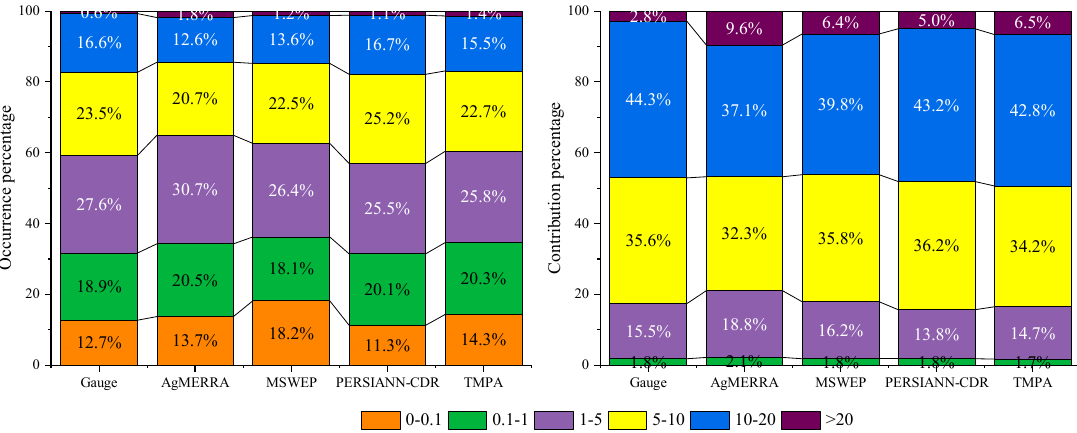
Figure 3. The intensity distribution of daily precipitation in different ranges (0~0.1, 0.1~1, 1~5, 5~10, 10~20, and >20 mm/day), and their relative contribution to the total precipitation amounts during the period 1998 to 2007 (Notation: the intensity of 0~0.1 contributed less rainfall (<1%), so it is not shown in the right corner of Figure 3).